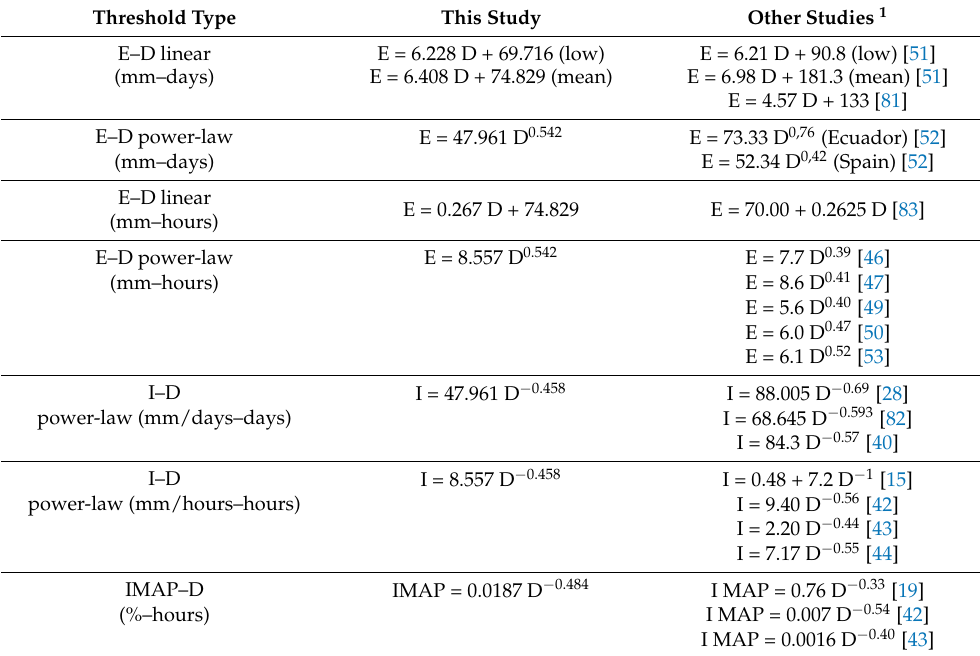
Table 7. Comparison of the calculated thresholds with those obtained by other